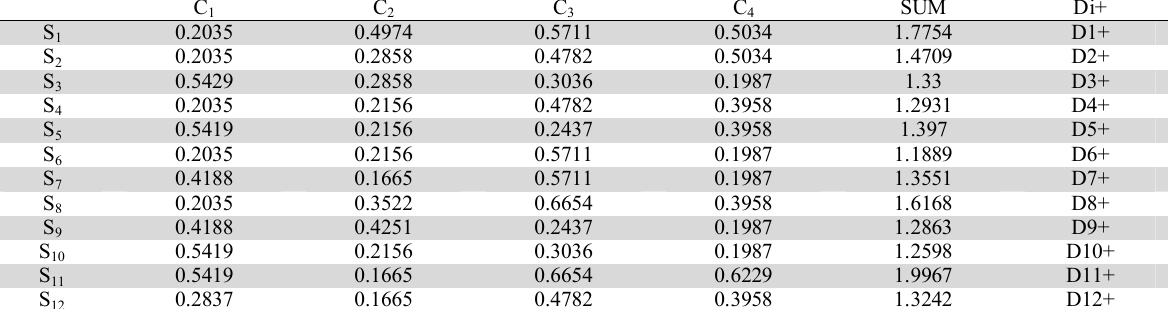
The summary of the results of the survey for the ideal positive factors